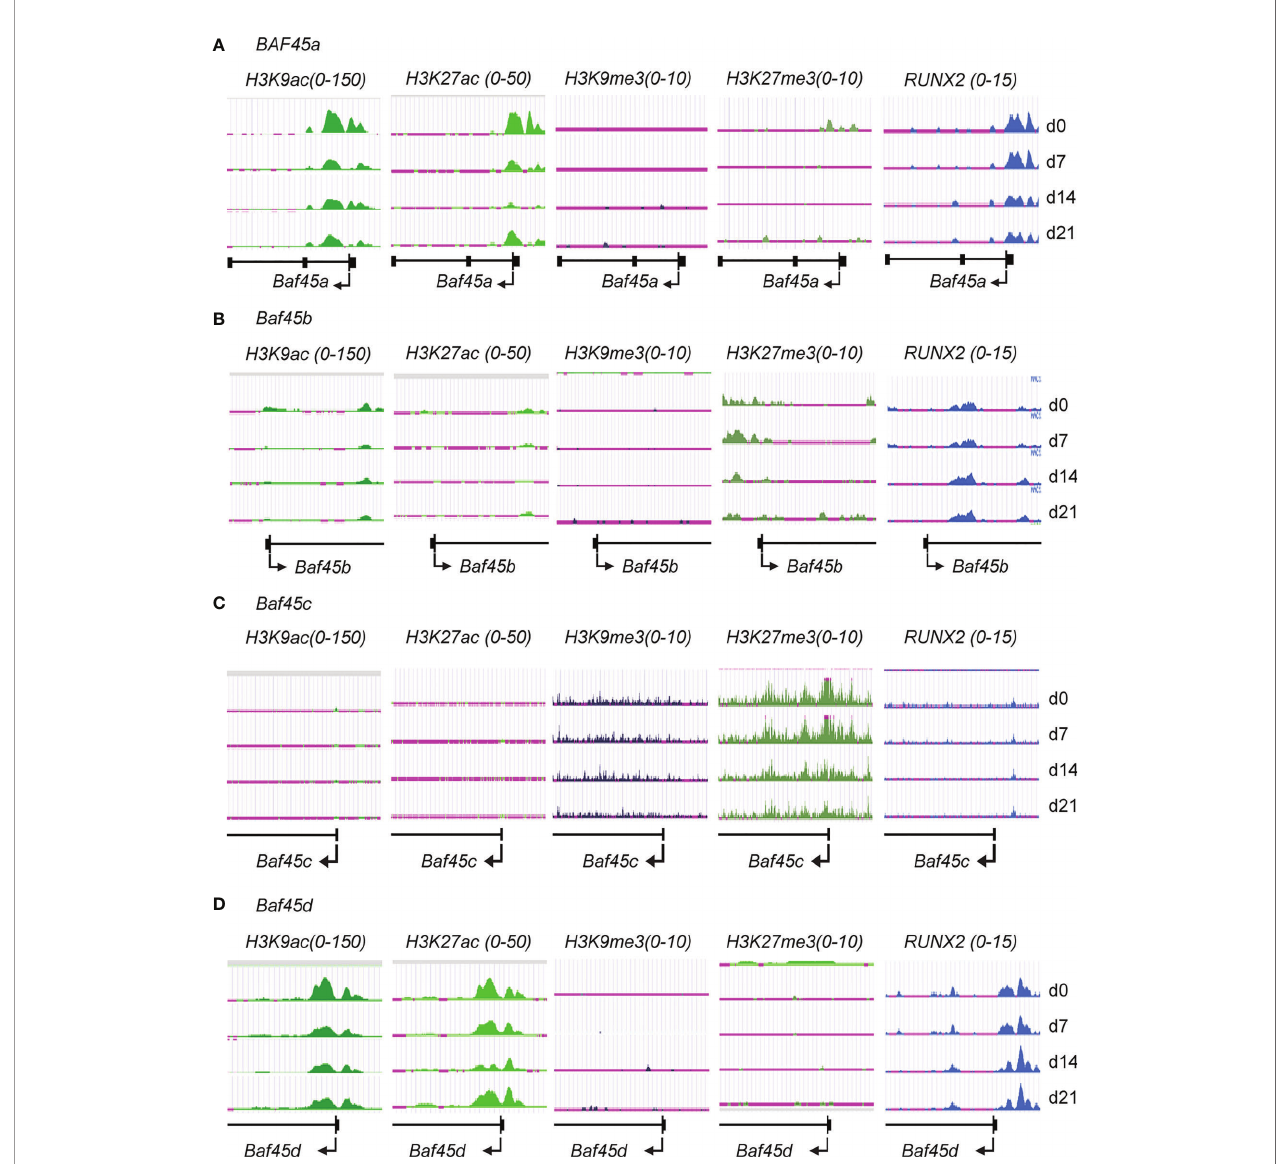
FIGURE 1 | Histone H3 modi fi cations and RUNX2 binding on the promoter regions indicate the accessibility of Baf45 homolog promoters during Bone Marrow Stromal Cells (BMSCs) differentiation. Comparison of ChIP-Seq data acquired by Illumina sequencing. BMSCs were isolated from the bone marrow of mice, grown, and differentiated under osteogenic differentiation conditions, harvested at days 0, 7, 14, and 21, and ChIP-sequencing was performed. H3K27ac, H3K27me3, H3K9ac, H3K9me3, and RUNX2 antibodies were used to immunoprecipitate protein-DNA interactome (A) Genomic tracks display ChIP-seq data showing enrichment pro fi les for H3K27ac, H3K27me3, H3K9ac, H3K9me3, and RUNX2 at (A) Baf45a , (B) Baf45b , (C) Baf45c and (D) Baf45d gene promoters. Quantitative peaks representing active chromatin marks H3K9ac and H3K27ac and peaks representing repressive chromatin marks H3K9me3 and